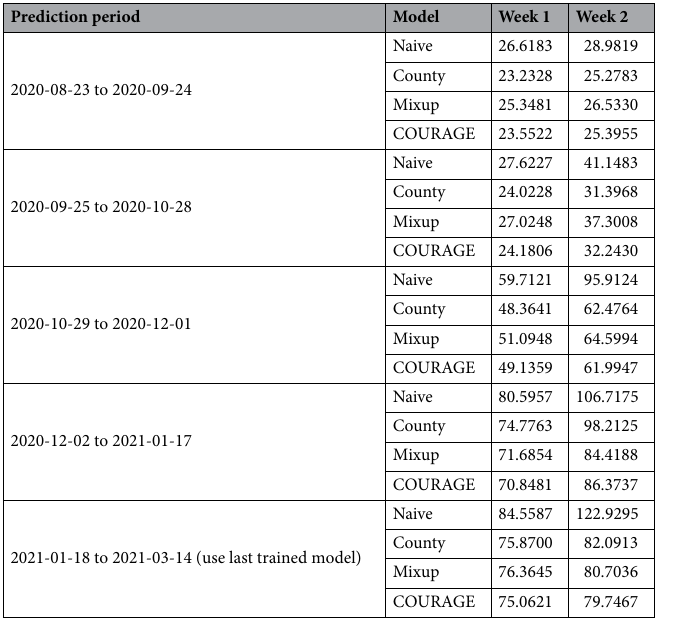
Table 2. Different prediction periods for the weekly total number of deaths. The prediction metrics reported is MAE.